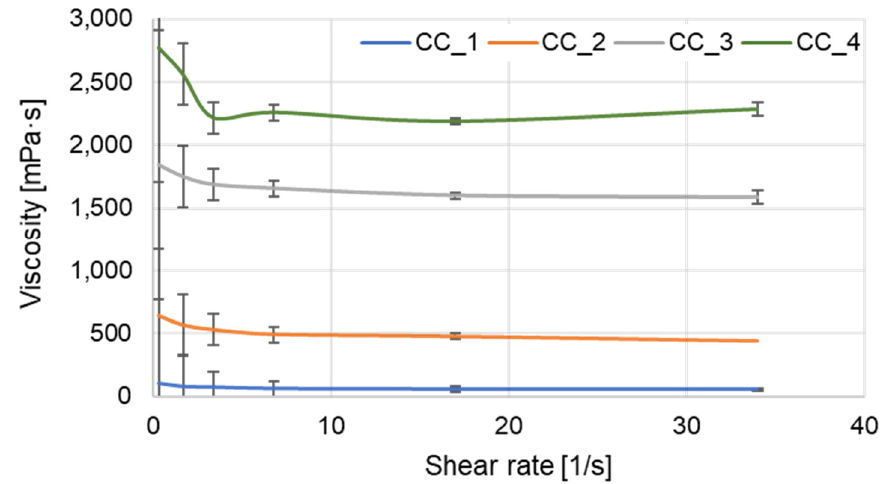
Figure 10. Shear rate dependence of viscosity for shower gel with digestate extracts.